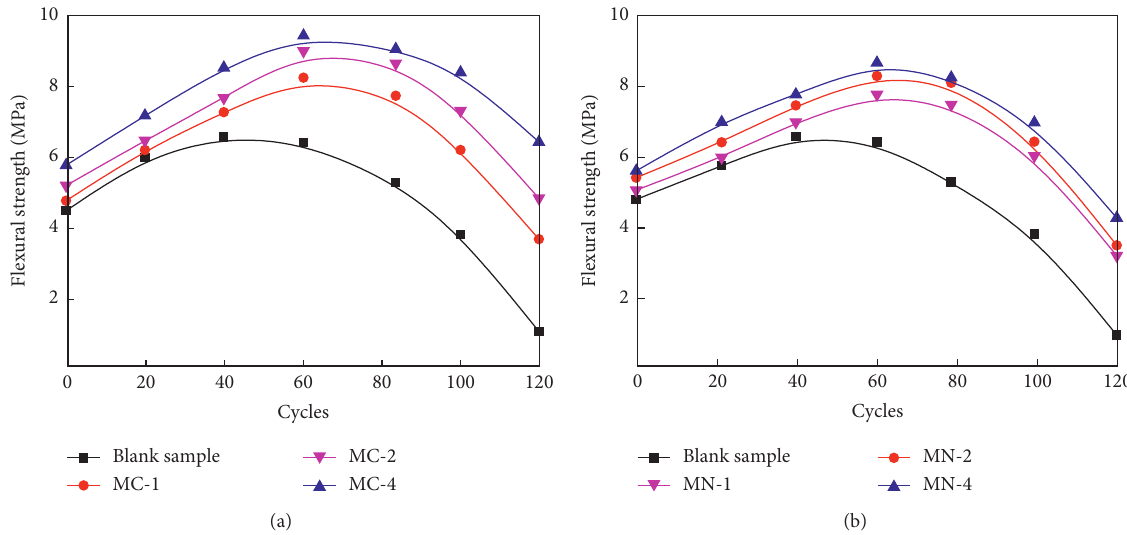
Figure 12: The flexural strength of mortar under dry-wetting cycles. (a) Mortar with N-LDH. (b) Mortar with